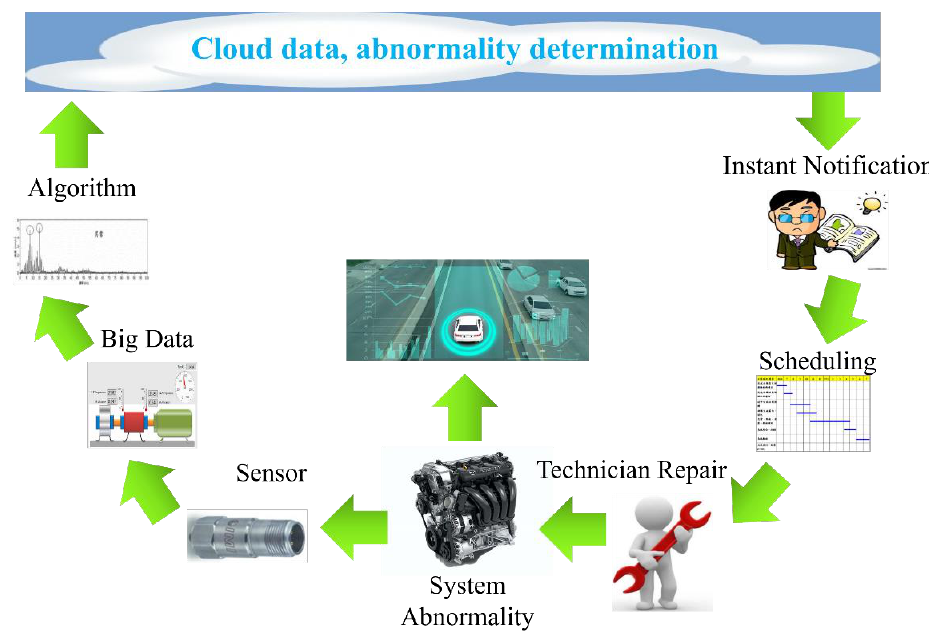
Figure 6. Schematic diagram of IoV fault prediction combined with cloud computing architecture.